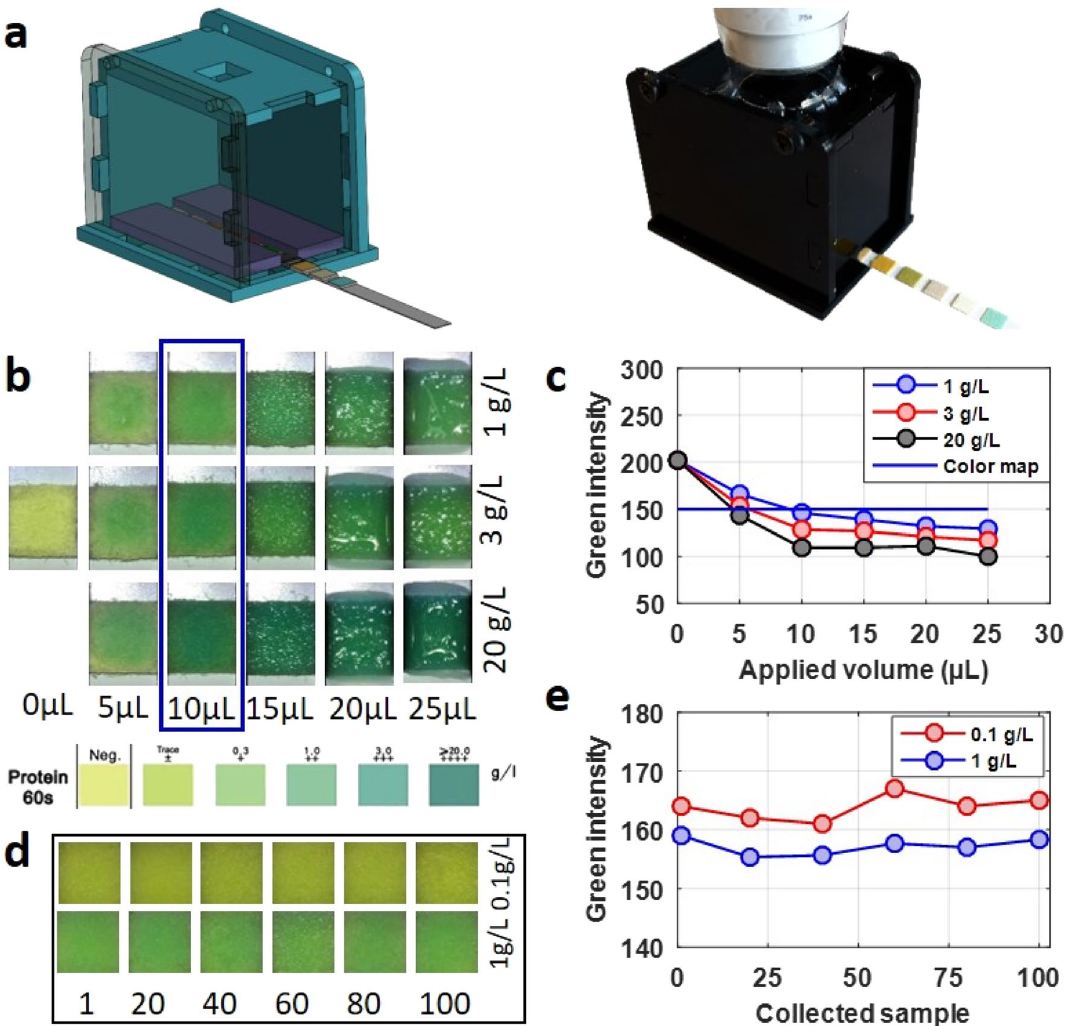
Figure 4. Characterization and validation of the setup with dipstick. ( a ) Imaging box to block outside light to capture an image of an inserted dipstick. Left: CAD drawing. Right: Assembled fabricated from laser-cut acrylic. ( b ) Optimization of the volume of liquid applied to the reagent strip. The results with different sample volumes are compared with the tabulated color map provided by the dipstick manufacturer. ( c ) Quantitative intensity analysis of the results shown in ( b ). ( d ) Strip color upon application of 10 µL of sample collected after running for one-hundred 3-h intervals. ( e ) Quantitative intensity analysis of the results shown in ( d